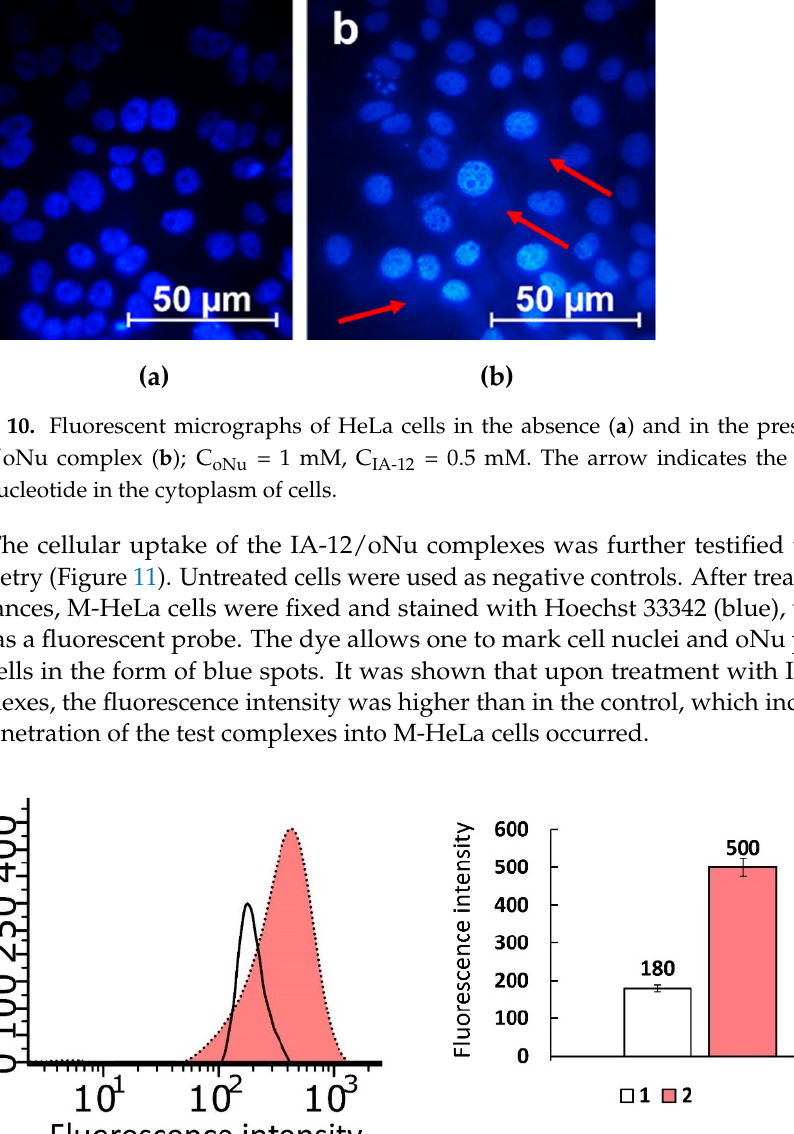
Figure 11. Cellular uptake study of the IA-12/oNu complex. 1—Intact M-HeLa cells; 2—M-HeLa cells in the presence of the IA-12/oNu complex.